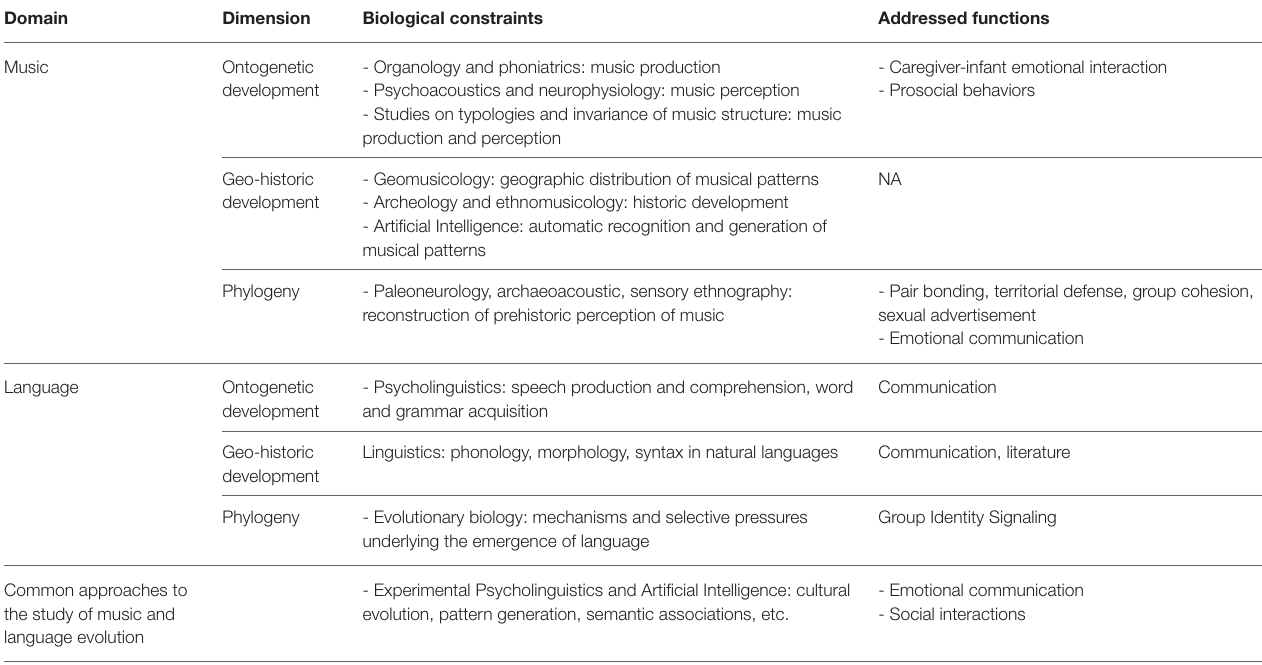
TABLE 1 | Disciplines which can contribute to understanding the evolution of musicality, and their correspondence with affine disciplines in the evolution of language.